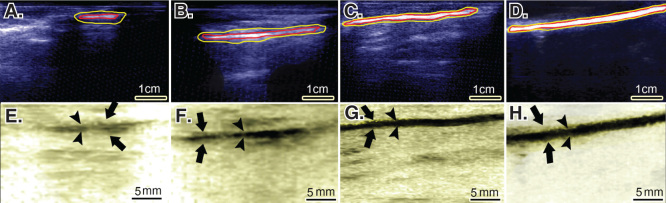

Ultrasonographical characteristics of the injured and normal tendons. Longitudinal sections.
A to D are regular ultrasonographs, while E to H are inverted ultrasonographs. Red border (inner border) shows the tendon, while the yellow or outer outline shows the peritendinous adhesions in the healing tendon (A to C) and the paratenon in the normal tendon (D). Arrows head show the tendinous tissue within the defect area or the contralateral part (E to H), while the arrows show the peritendinous adhesions (E to G) and paratenon (H). In the ICTs (A and E), the healing regenerated tissue in the defect area shows hypoechogenicity, irregularity and an amputated echo texture pattern is seen around the tendon. Treatment with CI alone, improved the echogenicity and homogenicity of the healing tendon and also reduced peritendinous adhesion (B and F). Compared to the controls (defect and CI alone), treatment with collagen-platelet implant markedly improved the echogenicity, homogenicity and alignment of the newly developed tendon in the injured area and it also considerably decreased the peritendinous adhesions (C and G). Normal ultrasonographic pattern of the rabbit’s Achilles tendon is provided for comparison (D and H).